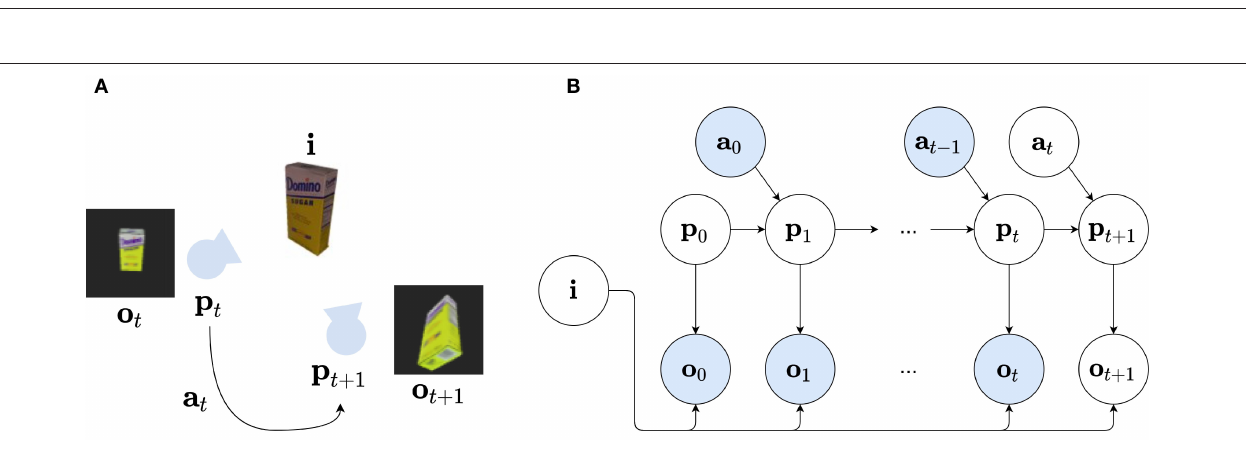
FIGURE 1 | (A) An observer’s view of the world is determined by its location l t and head direction h t at a timestep t , and the objects e i in the scene, their identity i i , and translation t i and rotation r i in the world coordinate frame. The observer can take action a t to move to another location. (B) A generative model of vision, simplified from Parr et al. (2021): starting from a scene s , we predict the objects or entities e i one might encounter, their identity i i and their placement in an allocentric reference frame defined by a translation t i and rotation r i . Together with the context c , i.e., the lighting conditions, and the viewpoint v t of the observer the observation o t is generated. Furthermore, the observer can change its viewpoint v t by taking actions a t that move its location l t and/or head direction h t . Both actions and observations are observed variables shown in blue, whereas the others are unobserved and shown in white.